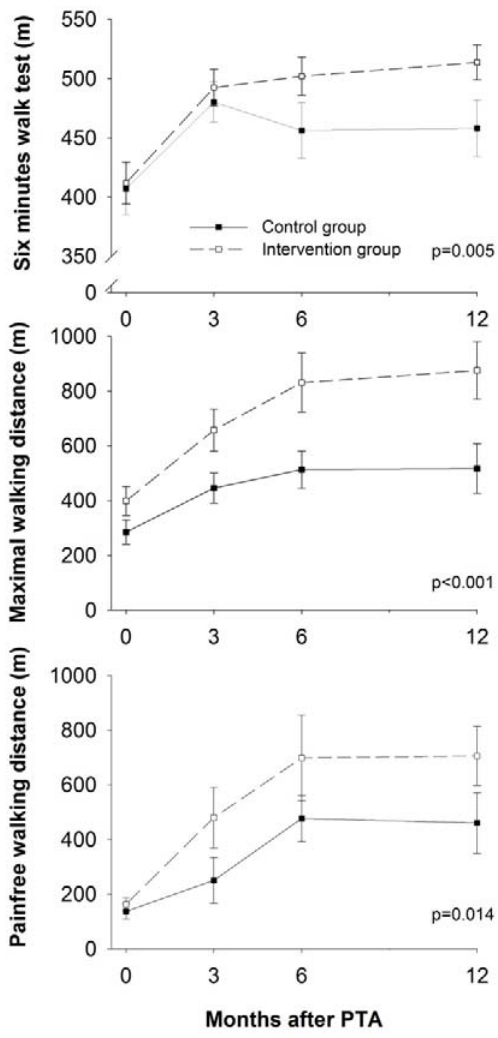
Figure 2. Walking distance. Values are mean, error bars indicate ±SEM. m =